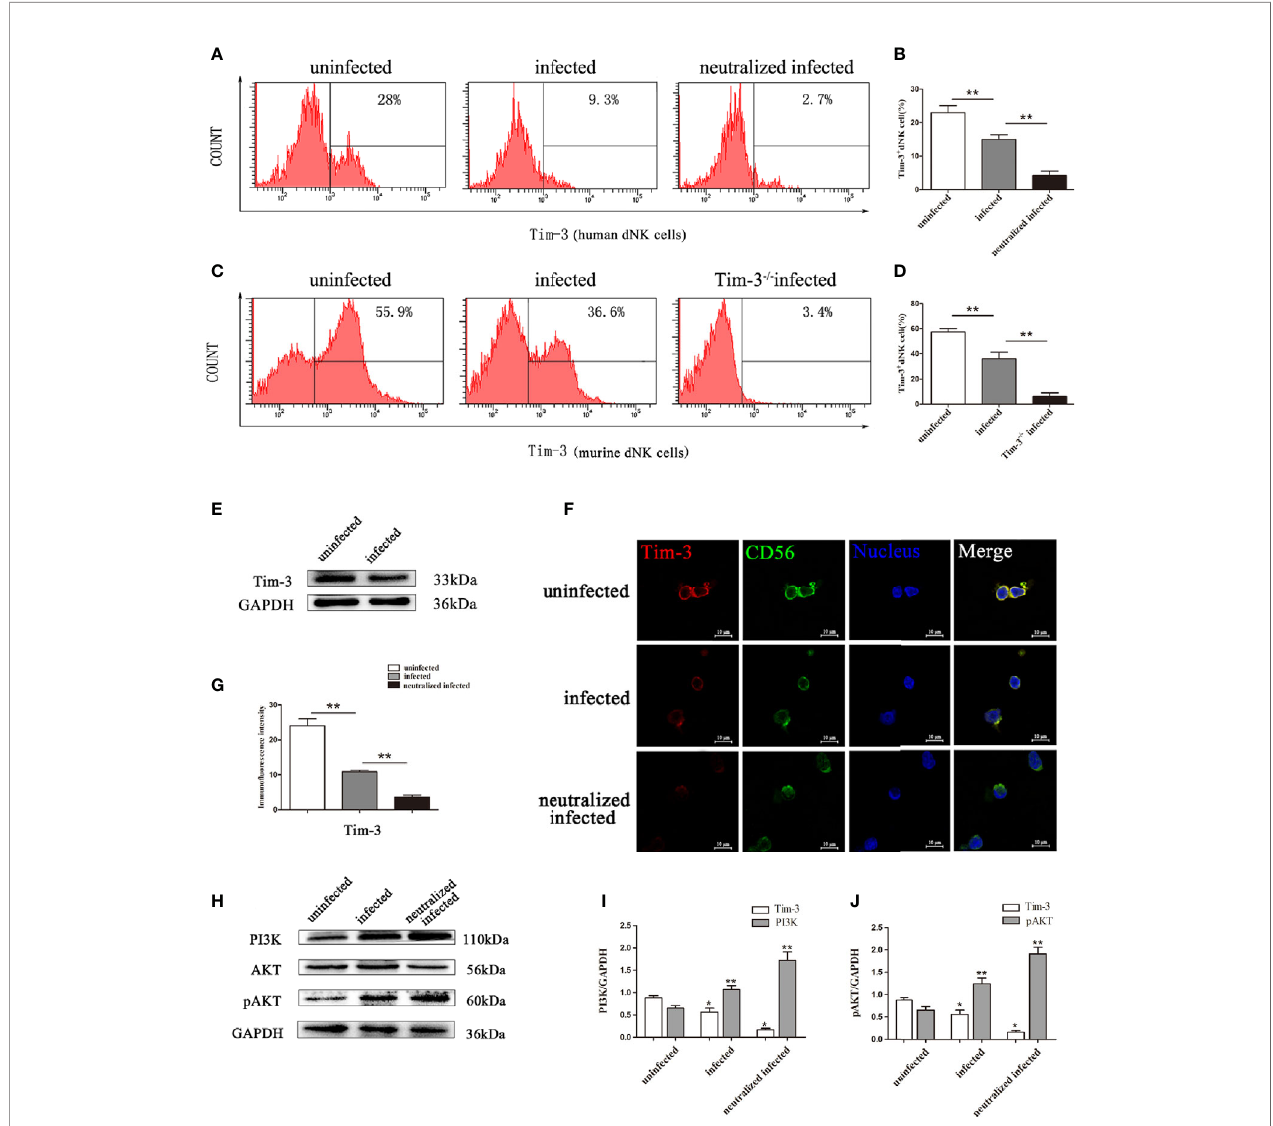
FIGURE 2 | Changes of Tim-3 expressions on dNK cells due to T. gondii infection. (A) Expression levels of Tim-3 on human CD3 - CD56 bright dNK cells in uninfected, infected, and anti-Tim-3 neutralized infected groups using fl ow cytometry. (B) Histograms analysis of Tim-3 expression changes on human dNK cells in the three groups. (Means ± SD; N=6 human samples per group, * p < 0.05, ** p < 0.01, by unpaired t -test). (C) Expression of Tim-3 on mice CD3 - CD122 + dNK cells in uninfected, infected, and Tim-3 -/- mice infected groups were detected by fl ow cytometry. (D) Histograms analysis of Tim-3 expression changes on mice dNK cells in uninfected, infected, and Tim-3 -/- mice infected groups. (Means ± SD, N=8 mice per group, * p < 0.05, ** p < 0.01, by unpaired t -test). (E) Western blot analysis of Tim-3 expression in uninfected human dNK cells and infected groups. (F) Immuno fl uorescent photographs of Tim-3 (red), CD56 (green) expression on the puri fi ed human CD3 - CD56 bright dNK cells from uninfected, infected, and Tim-3-neutralized and infected groups. The 4 ‘ , 6-diamidino-2-phenylindole were used to stain nuclei (blue). Scale bar, 10µm. (G) Histograms analysis of Tim-3 expressions changes on human dNK cells by immuno fl uorescent intensity among three groups. (H) Representative depictions of Tim-3 downstream molecules PI3K, AKT and pAKT expressions in uninfected, infected, and Tim-3-neutralized infected human dNK cells by western blot. (I, J) The histograms analysis of Tim-3, PI3K and pAKT among three groups. (Means ± SD; N=6 human samples per group, * p < 0.05, ** p < 0.01, by unpaired t